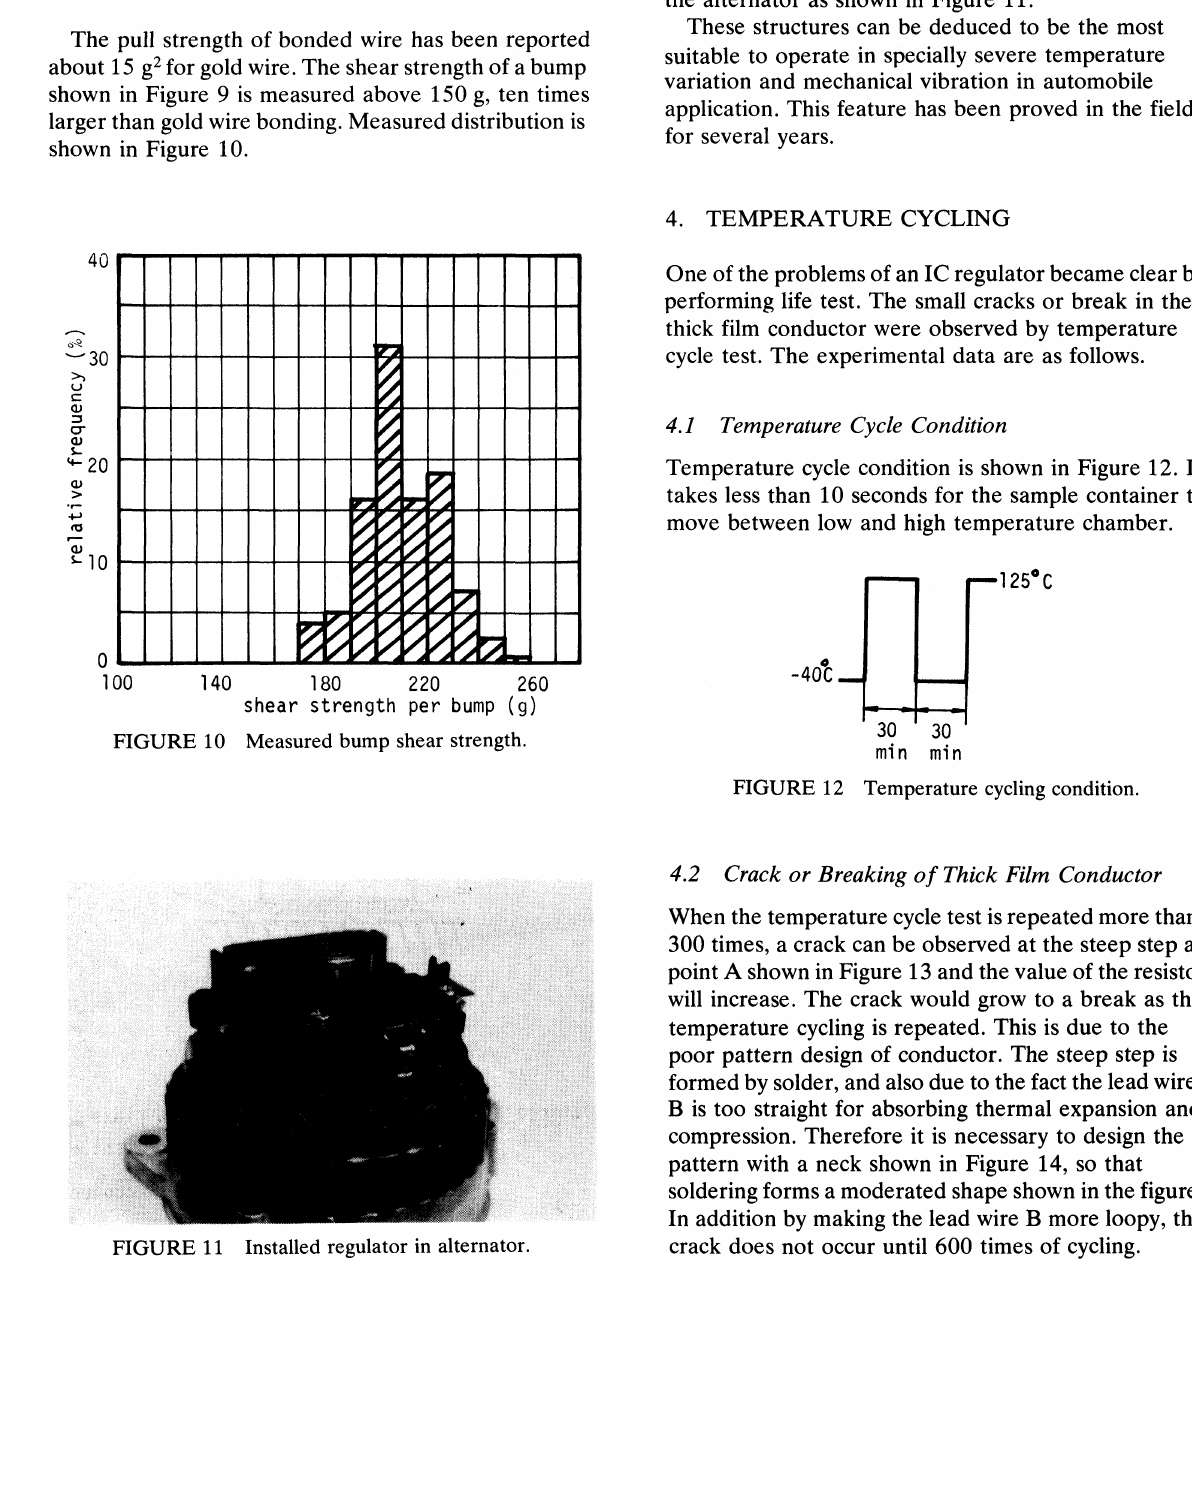
FIGURE 9 Bump shear strength measurement.